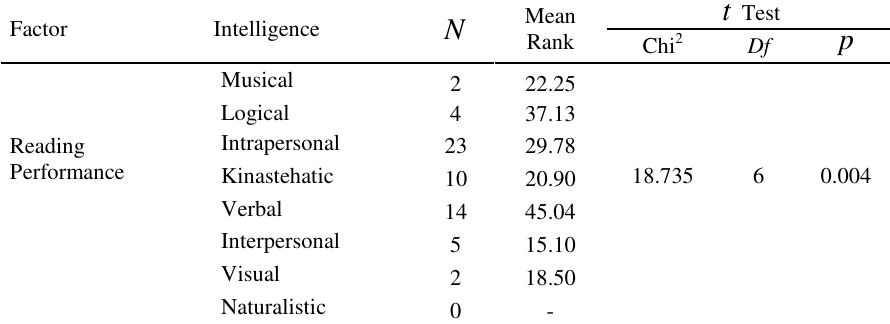
Table 3 Kruskal Wallis H Test for Reading Performance & MI